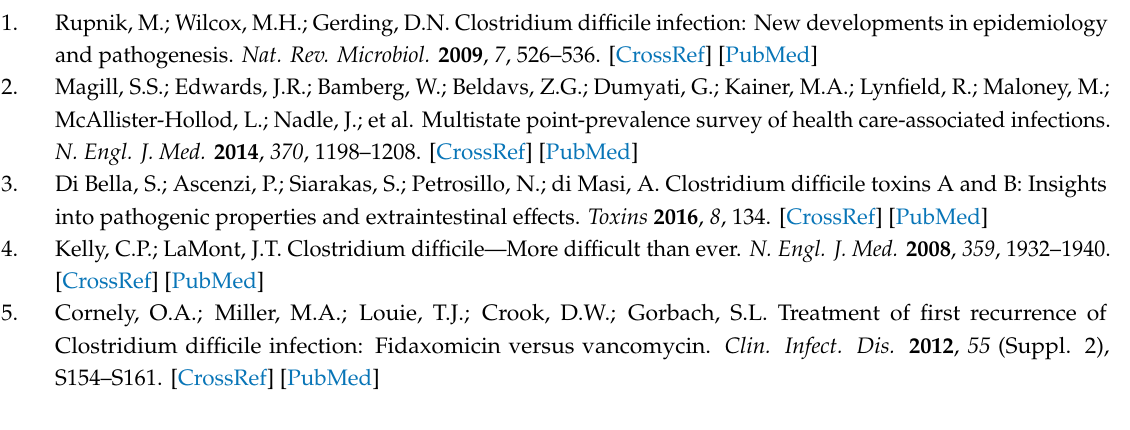
Table S1: Demographic and selected clinical characteristics of cases and control of the original study and the subsample included in the current